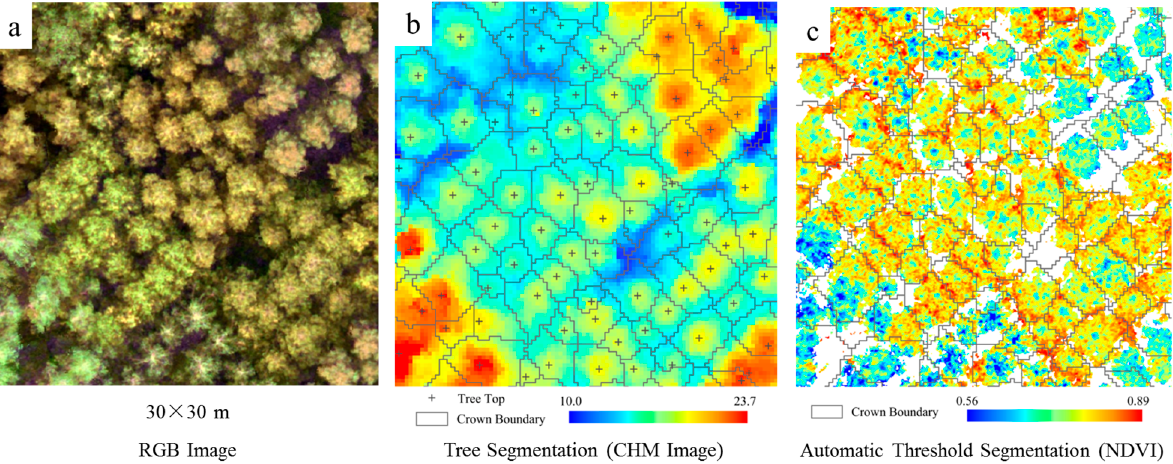
Figure 4. Example of segmentation results. The size of the selected area was 30 m × 30 m. ( a ) Original RGB orthophoto; ( b ) individual tree segmentation results folded on a canopy height model (CHM); ( c ) normalized difference vegetation index (NDVI) map after an automatic threshold segmentation. The gray lines represent the individual-tree boundaries identified by the algorithm, and the cross symbols represent the crown vertex.